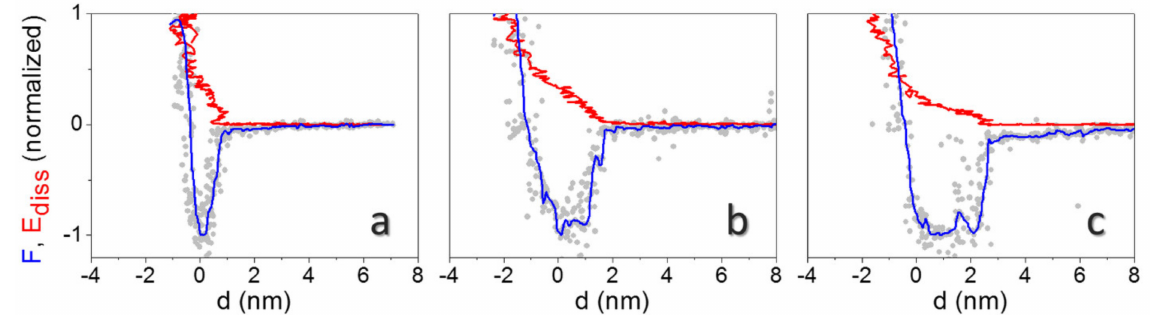
Figure 4. Typical normalized reconstructed F (grey dots: raw data; blue line: data after smoothing) and E diss curves (red line) on top of individual virions at RH < 10% ( a ), 56% ( b ), and >100% ( c ). Curves were obtained from APD curves collected at free amplitude A 0 = 27 nm. F ad = 2.1 nN ( a ), 0.75 nN ( b ), and 1.1 nN ( c ). E max = 64 eV ( a ), 51 eV ( b ) and 71 eV ( c